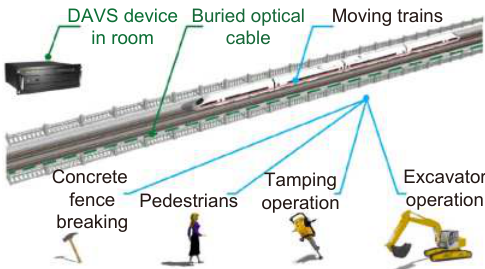
Fig. 9 | An illustration of the railway safety monitoring experi- ments. Figure reproduced from ref. 108 , under the OSA Open Access Publishing Agreement.